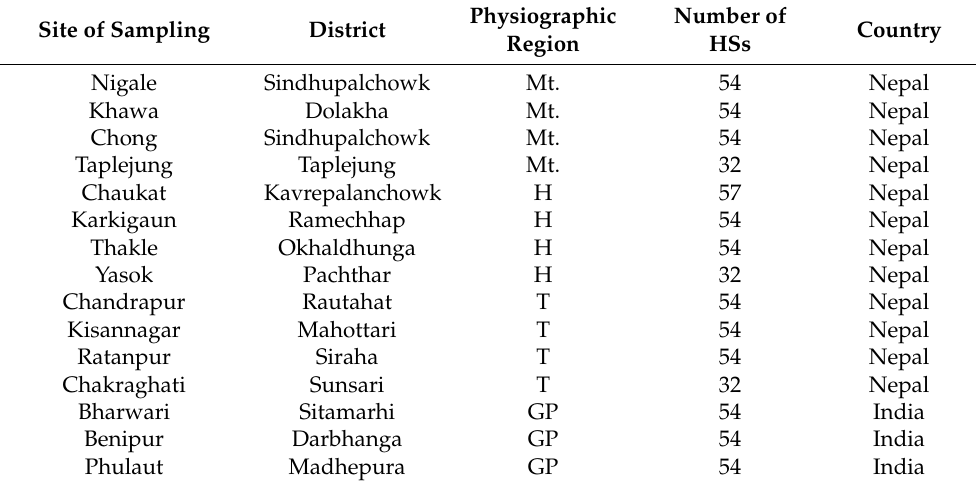
Table 1. Details of the sampled sites in the trans-boundary Koshi River